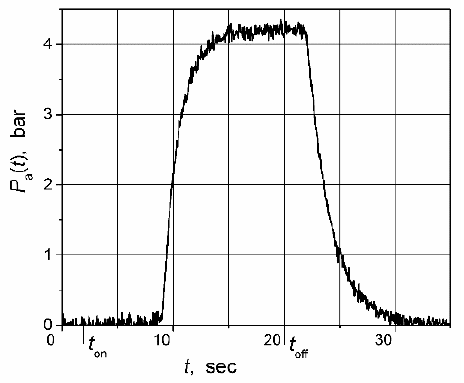
Figure 14. Open-loop pulse response of the water pressure of water supply system. The AC motor drive was switched on at time moment t on = 2 s, and shut down at time moment t off = 20 s.